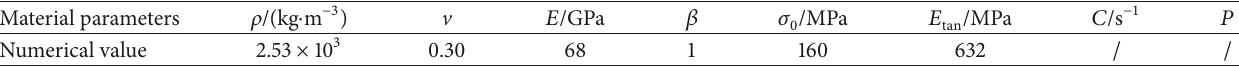
Table 2: Material parameters of the car-body